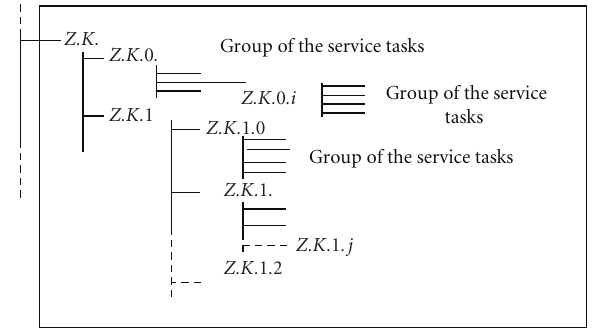
Figure 5: Fragment of the task tree for Z = Z.K : K -index name, symbol “0” indicates service tasks, other names indicate the problem-oriented